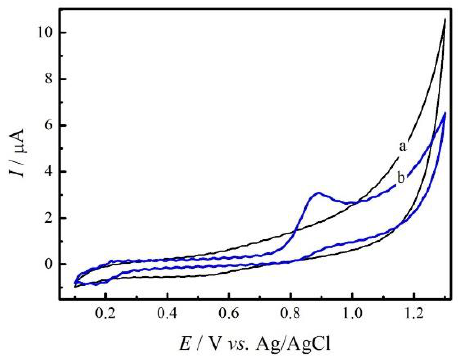
Figure 6. Electrochemical characterization of SMZ in 0.2 mol L −1 PBS pH 8.0 in the absence